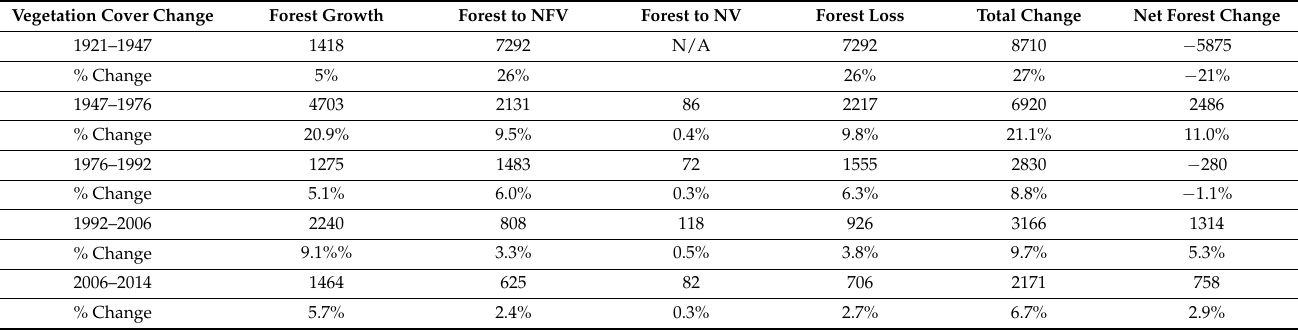
Table 4. Categories of vegetation cover change by area (ha) and percent of relative forest or total non-mangrove landcover from 1947 to 2014. NFV = non-forest vegetation, and NV =